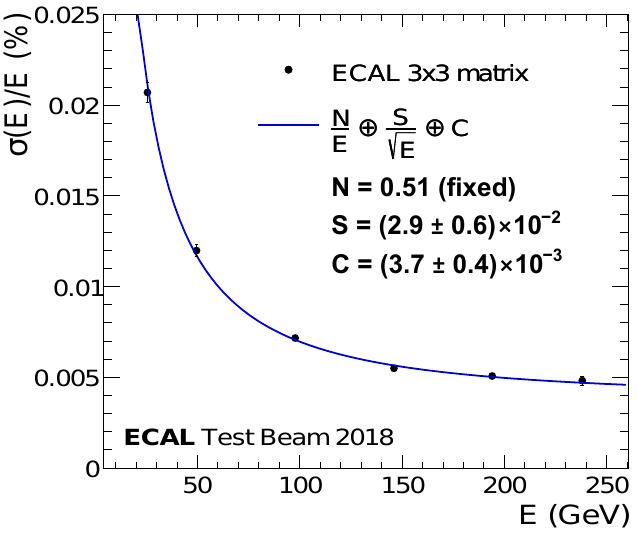
Figure 13. Energy resolution of a 3 × 3 crystal matrix as a function of the deposited energy obtained in 2018 test beam data.The solid blue line represents the fit with the energy resolution function √ N / E ⊕ S / E ⊕ C , where N denotes the noise, S the stochastic term, C the constant term, and E the deposited